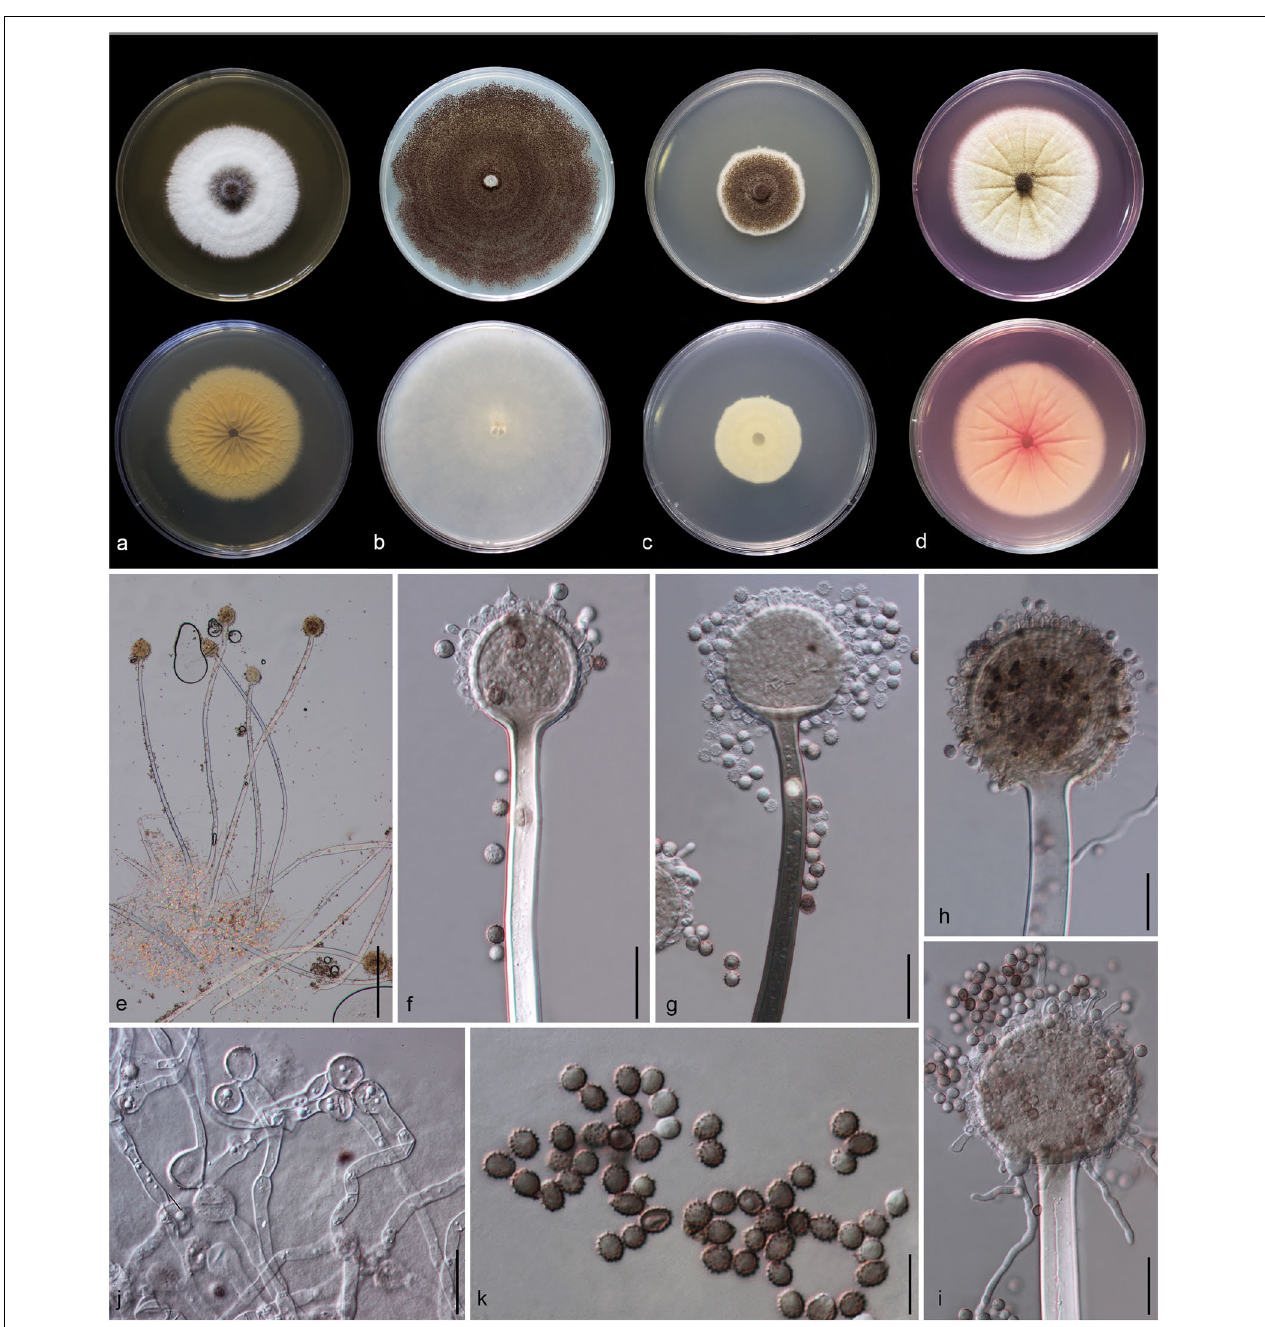
FIGURE 5 | Aspergillus hydei (MFLU 20-0430, holotype). (a–d) Colonies on MEA, CYA, PDA and Rosebengal at 25 ◦ C, respectively. (e) Conidiophores. (f–i) Close-up of conidiophores, vesicle, phialides, and conidia ( f,g: exhibiting colors of polarized light under DIC illumination). (j) Chlamydospores. (k) Conidia. Scale bars: (e) = 200 µ m, (f–j) = 20 µ m, (k) = 10 µ